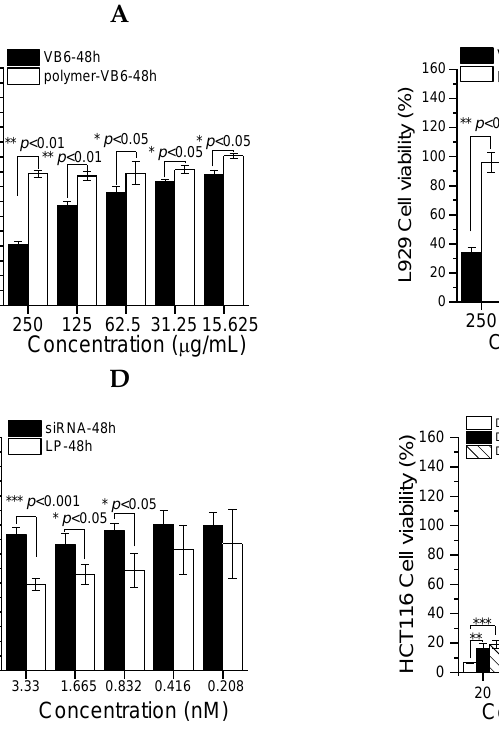
Figure 6. Cytotoxicity of lipopolyplexes in HCT116 cancer cells and L929 fibroblasts. ( A ) HCT116 cells and ( B ) L929 fibroblasts treated with VB6 and P(HPMA-co-MA-hyd-VB6) (Polymer-VB6) for 48 h. Free FAK siRNA and LP incubated with ( C ) HCT116 cells and ( D ) L929 for 48 h. ( E ) HCT116 cells and ( F ) L929 fibroblasts treated with free DOX, DL and DLP for 48 h. Data were presented as mean ± SD ( n = 3). * p < 0.05, ** p < 0.01 and *** p < 0.001.